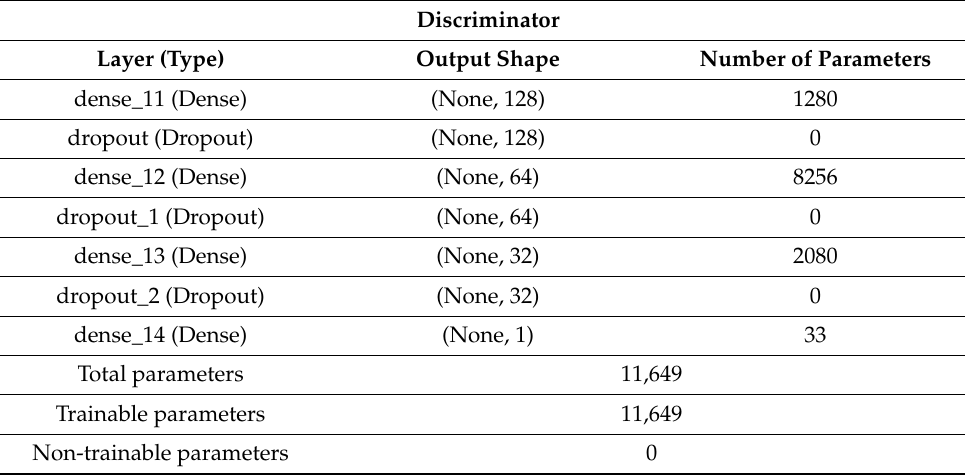
Table 3. Discriminator model